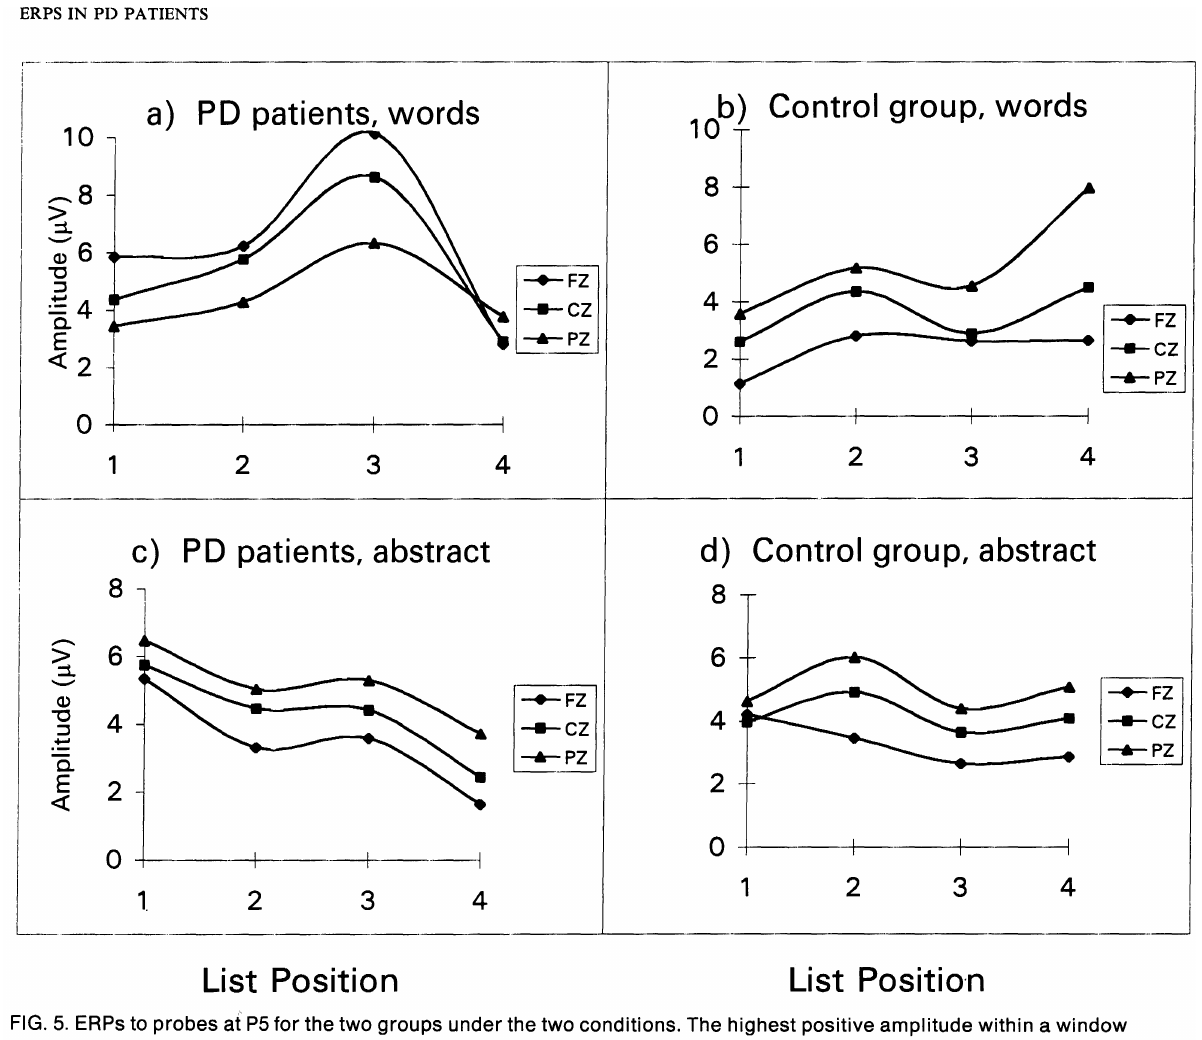
FIG. 5. ERPs to probes at P5 for the two groups under the two conditions. The highest positive amplitude within a window from 450-630 ms was